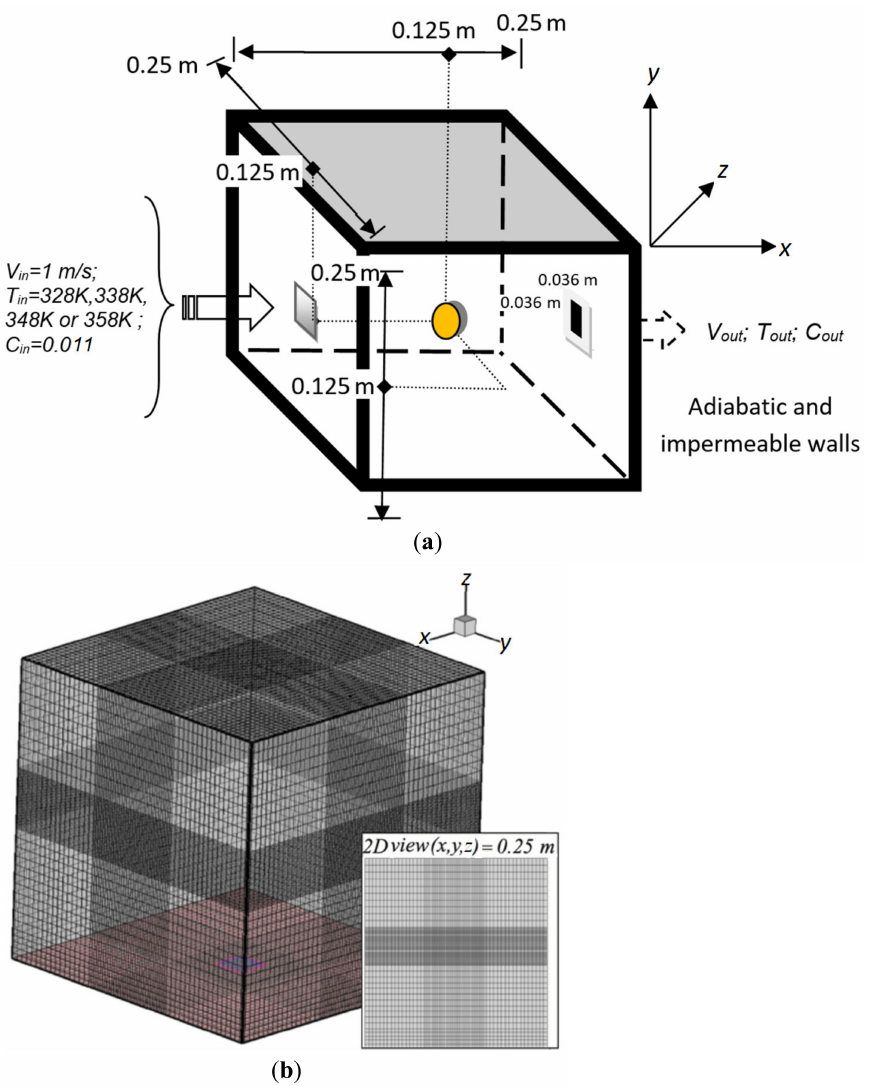
Figure 1. ( a ) Physical set-up for the experiments and simulations, and ( b ) optimal computational grid used in the simulations with a denser grid in the fruit